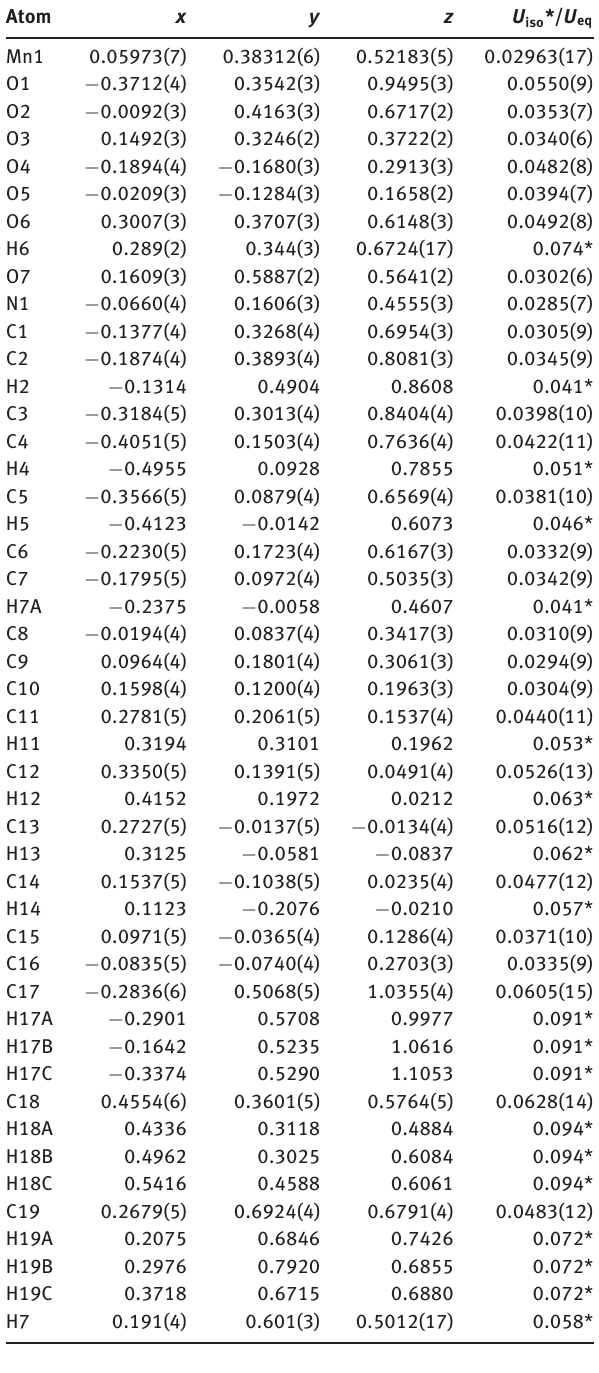
Table 2: Fractional atomic coordinates and isotropic or equivalent isotropic displacement parameters (Å 2